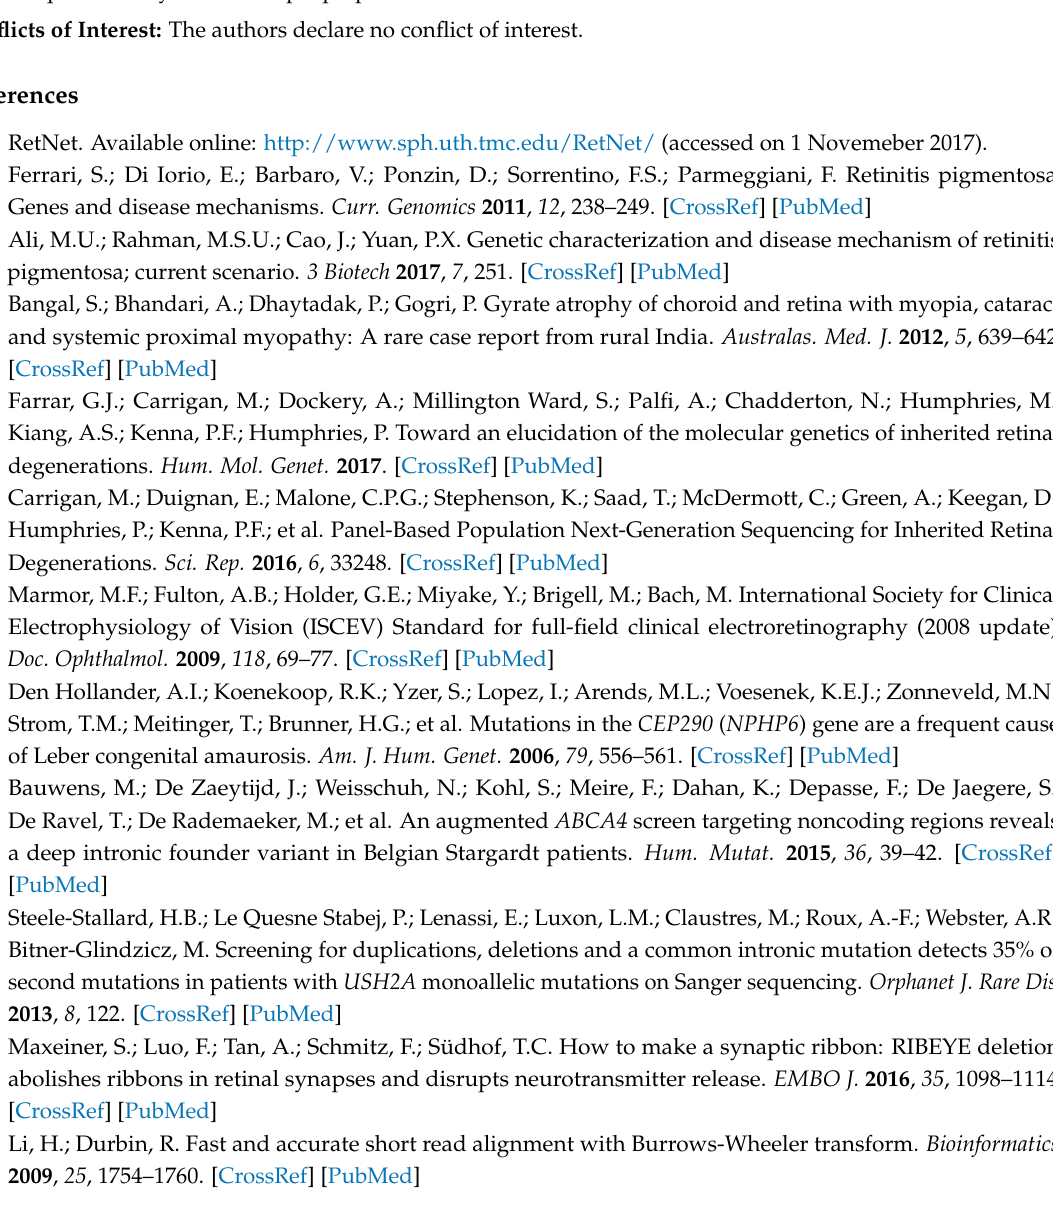
Figure S1: An illustration of the PCR strategy designed to detect a large homozygous inversion; Figure S2: Confirmation of an OAT inversion using strategic PCR design; Figure S3: Gel confirmation of USH2A deletion; Figure S4: Sanger sequencing trace of USH2A mutation, p.Cys759Phe; Figure S5. Analysis of USH1C deletion by use of PCR products, Table S1: Full list of genes captured in NGS